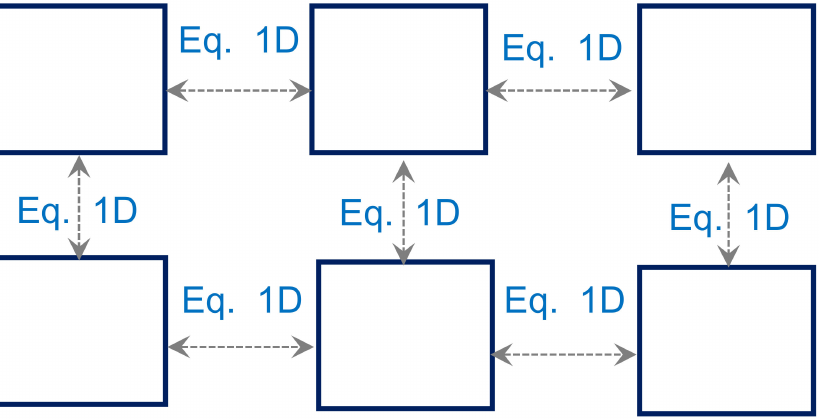
Figure 3. Schematic representation of the connection between MODCEL-raster